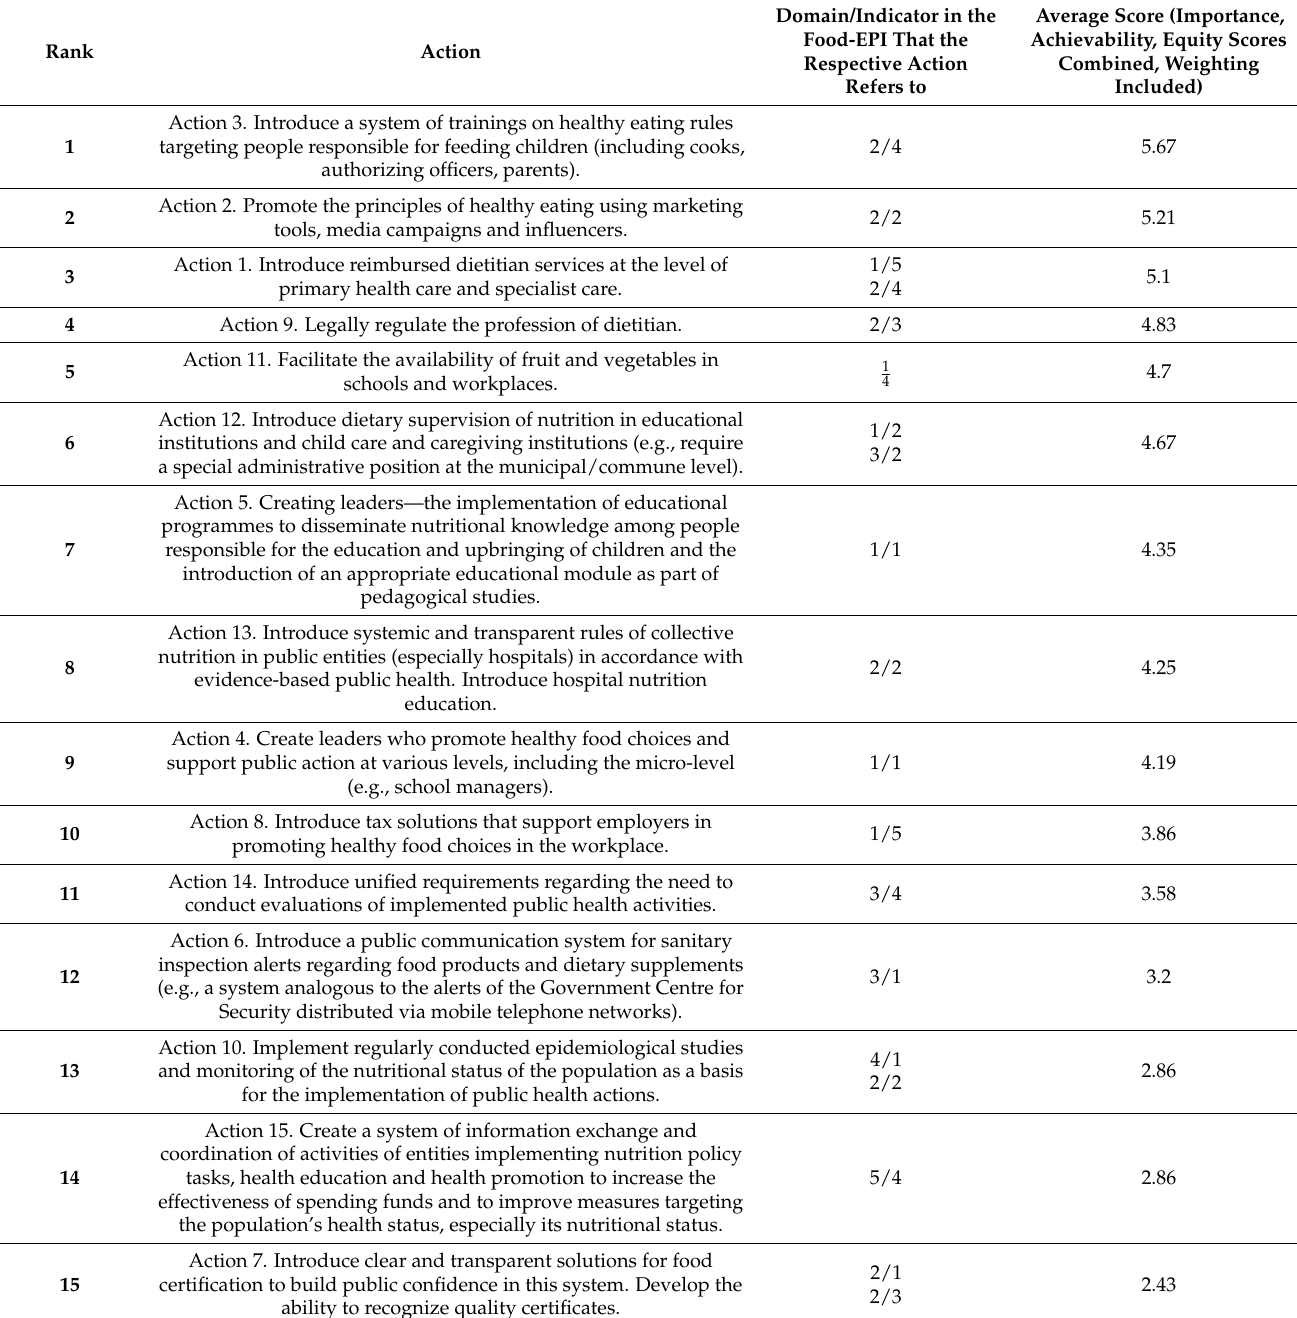
Table 2. Infrastructure-related actions recommended for improving the Polish healthy food envi- ronment, ranked by priority. The action labels (action 1, action 2, . . . ) are taken from the original document sent for prioritisation by